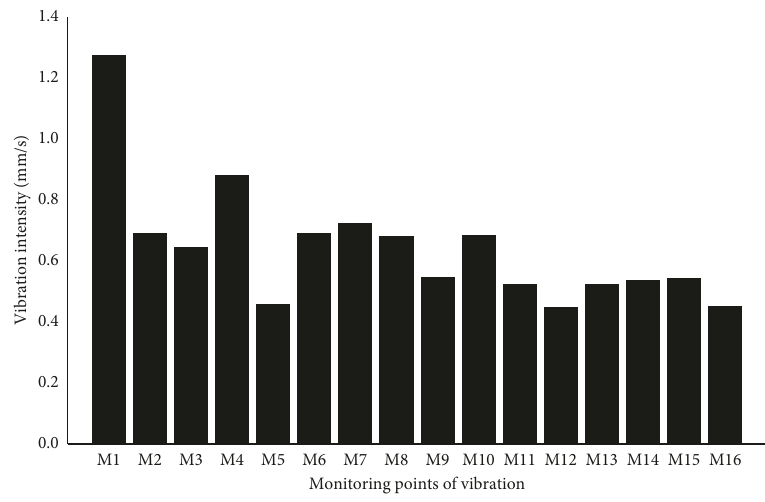
Figure 11: Vibration intensity at each monitoring point. Table 2: Vibration intensity at monitoring points M3 and M4 (unit: